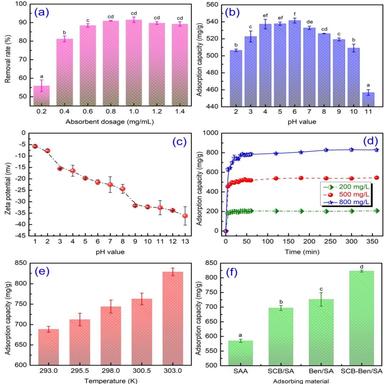
(a) Effect of SCB–Ben/SA dosage on CV removal at adsorption equilibrium (temperature, 303 K; pH, 4; and initial dye concentration, 500 mg/L). (b) Effect of pH on the equilibrium adsorption capacity of SCB–Ben/SA for CV (adsorbent dosage, 0.8 mg/mL; temperature, 303 K; and initial dye concentration, 500 mg/L). (c) Effect of pH on the zeta potential of SCB–Ben/SA (0.8 mg/mL). (d) Effects of contact time and initial dye concentration on the adsorption capacity of SCB–Ben/SA for CV (adsorbent dosage, 0.8 mg/mL